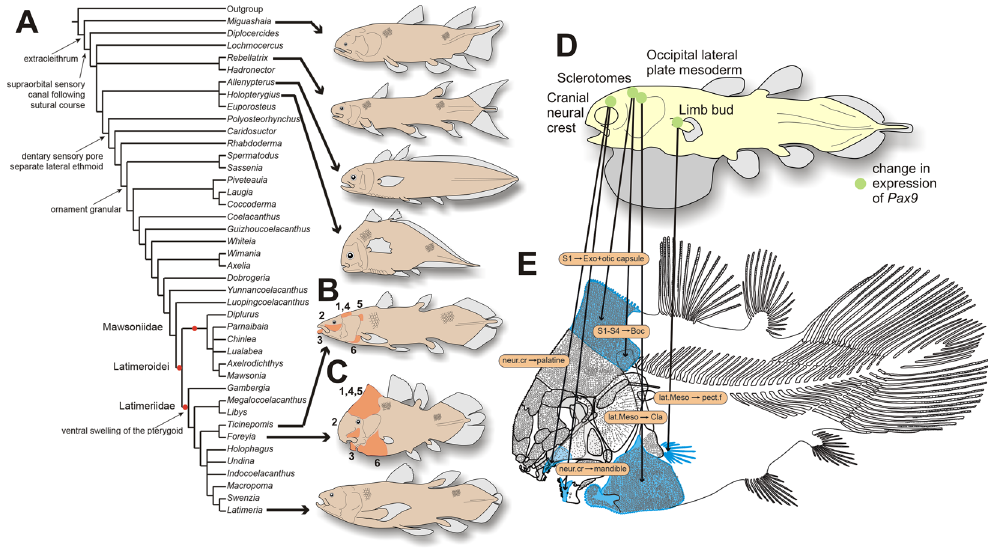
Figure 3. Phylogenetic relationships of Foreyia maxkuhni gen. et sp. nov. and developmental origin of the derived characters. ( A ) Strict consensus trees of the 259 most parsimonious trees of 317 steps (CI = 0.3817, RI = 0.6766) with some of the uniquely derived characters present in Foreyia maxkuhni on the left, and reconstructions of genera with atypical general morphology. ( B and C ) Shared features of Ticinepomis peyeri and Foreyia maxkuhni (in orange) not included in the cladistics analysis (see main text for numbers). ( D ) Reconstruction of a coelacanth embryo with localization of embryonic tissues that give rise the derived skeletal features present in Foreyia . It is hypothesized that changes in the expression of Pax9 may have altered the derived characters shown in blue on the reconstruction ( E ). All the drawings were made by LC. Abbreviation: Boc, basioccipital; Cla, clavicle; Exo, exoccipital; lat. Meso., lateral mesoderm; neur. cr., neural crest; pect. f., pectoral fin; S (numbered),